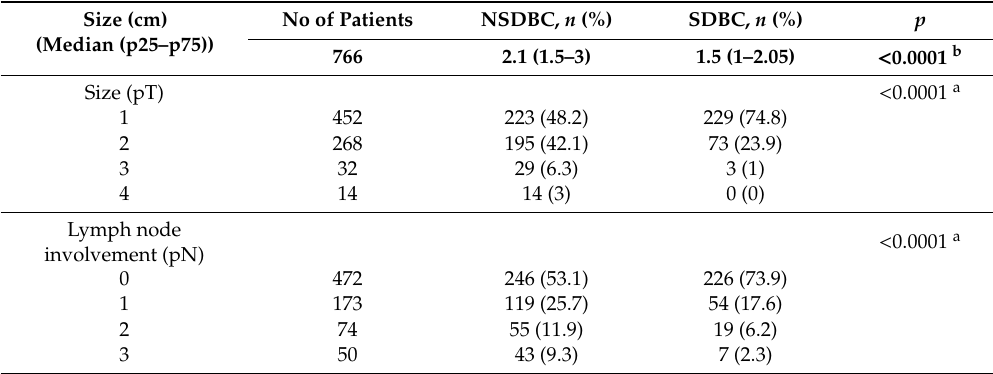
Table 2. Histopathologic di ff erences between screen detected breast cancers (SDBC) (Programa